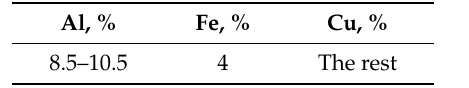
Table 5. The Fe–Al bronze chemical composition.